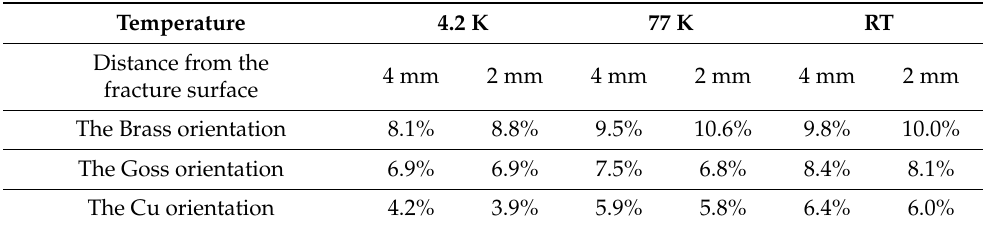
Table 2. Volume fractions of key austenite orientations depending on temperature and distance from the specimen fracture surface.